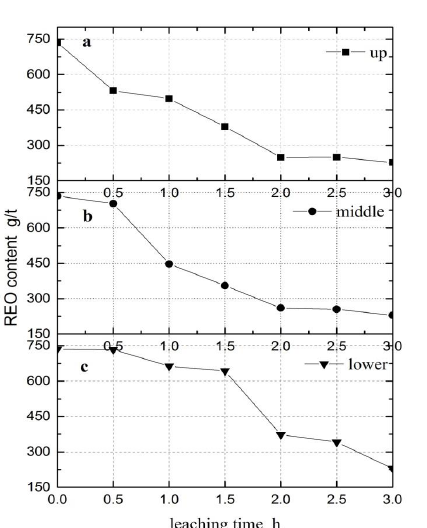
Figure 6. Comparison of REO contents of the sample during the (NH 4 ) 2 SO 4 solution leaching test. ( a–c ): the REO content plot of the upper ( a ), middle ( b ) and lower ( c ) part of the sample.